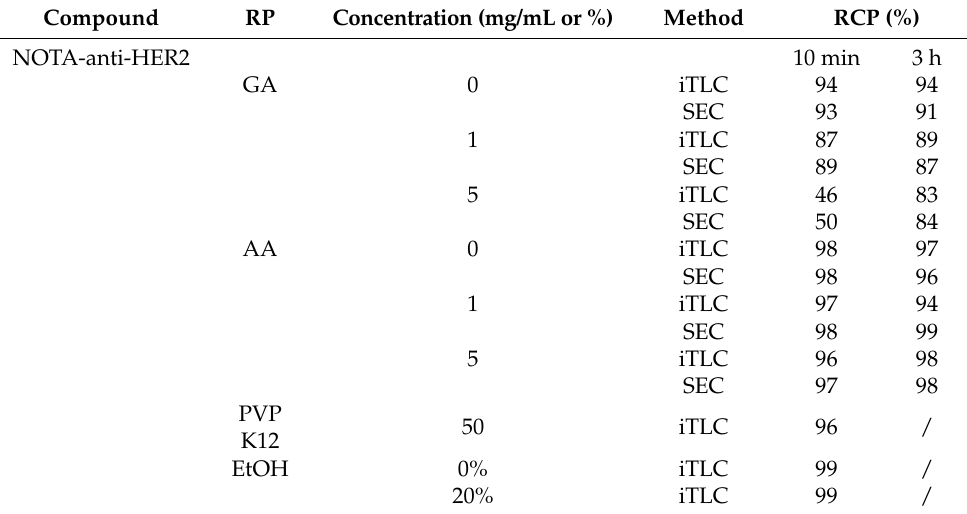
Table 1. Compatibility test of different radioprotectants for the 68Ga labeling of NOTA-sdAb.